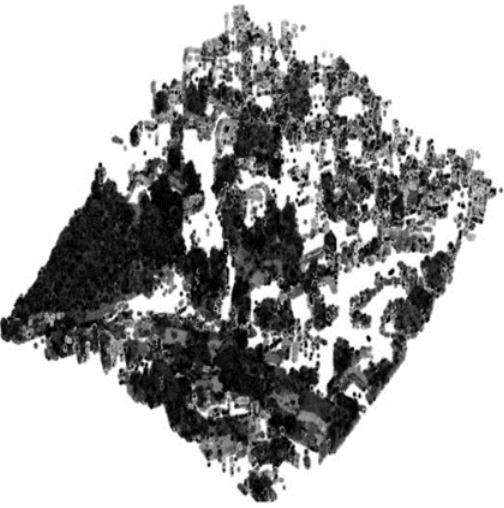
Figure 12: 3D information about vegetation